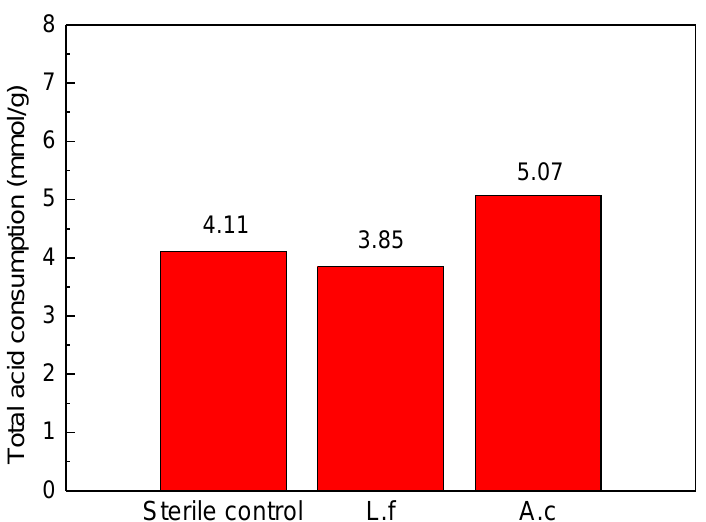
Figure 5. Total acid consumption of L. ferriphilum , A. caldus and sterile control during bornite bioleaching.